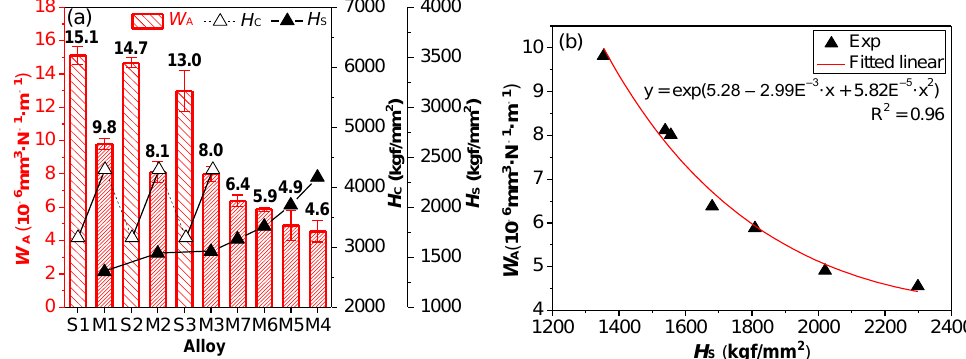
Figure 11. Relationships between wear rates W A of coated cemented carbides in air and H C (or H S ): ( a ) the comparisons of the variation trends between W A , H C (or H S ); ( b ) nonlinear fitting of the W A versus H S .